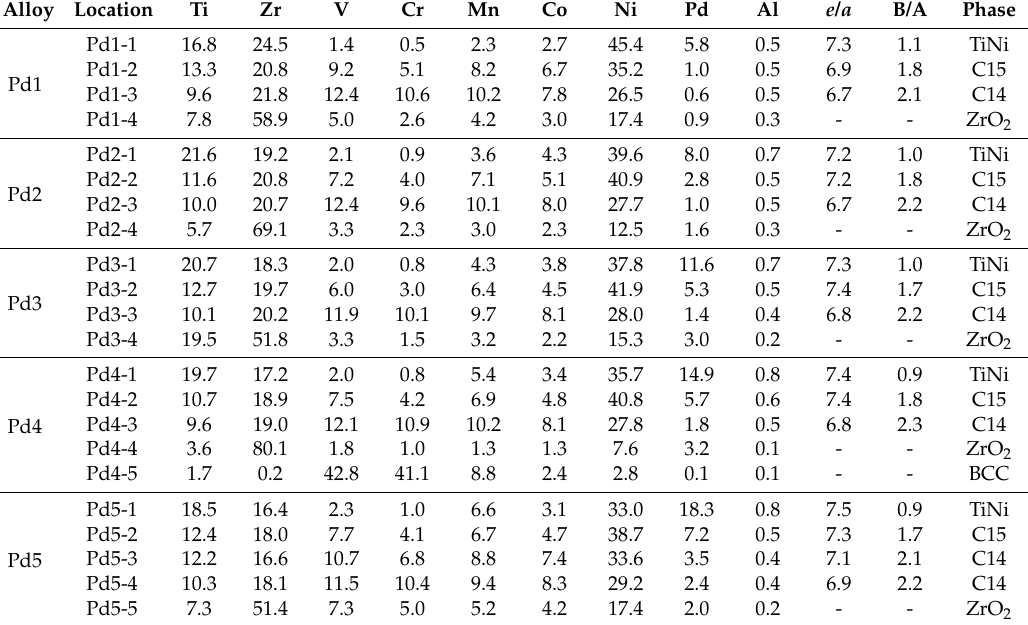
Figure 7. Evolution of the C14 lattice constant a / c ratio with increasing Zr ‐ content in the phase. Data for Zr/Ti and ZrTi/Pd series are from a prior work [103] and the current study, respectively. Table 5. Summary of the EDS results from several selective spots in the SEM ‐ BEI micrographs shown in Figure 4. All compositions are in at %. The main C14 phase is identified in bold . Alloy